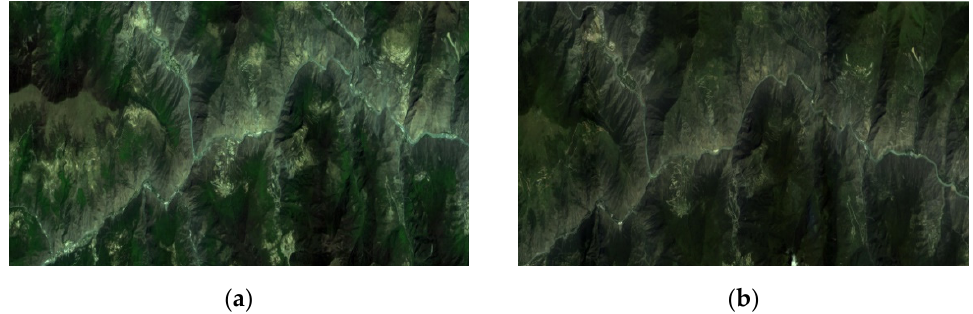
Figure 4. A GF-1 image pair: ( a ) acquired on 19 February 2015; ( b ) acquired on 11 May 2015.